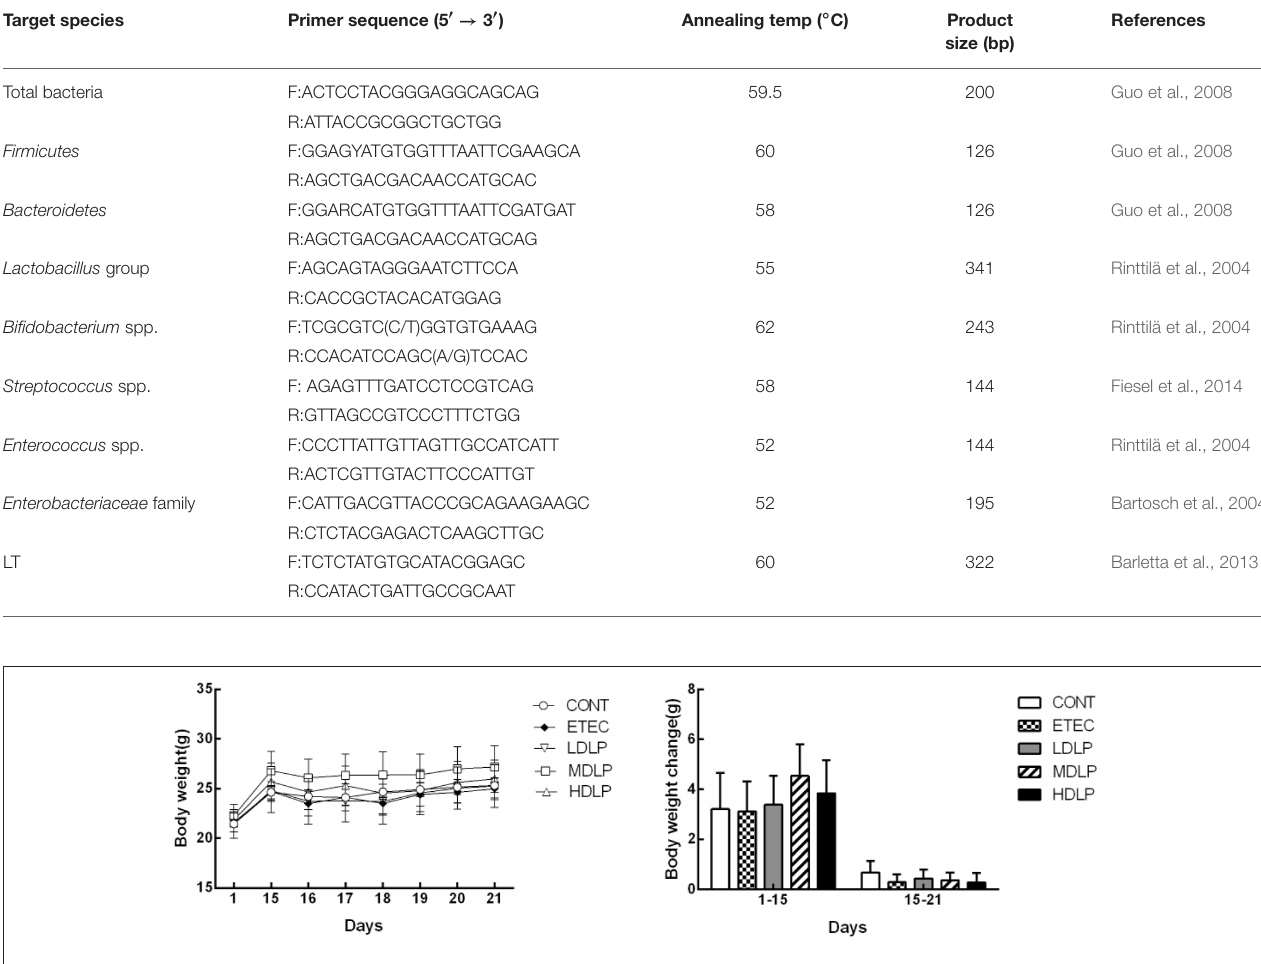
FIGURE 1 | Dose effect of Lactobacillus plantarum on the body weight of mice during pre- and post-challenge periods ( n = 6). CONT, control group, treatment with PBS at all period; ETEC, negative group, oral challenge with ETEC on day 15; LDLP, low dose (5.0 × 10 8 cfu mL − 1 ) group; MDLP, intermediate dose (5.0 × 10 9 cfu mL − 1 ) group; HDLP, high dose (5.0 × 10 10 cfu mL − 1 ) group; LDLP, MDLP, and HDLP groups were infected with ETEC at day 15. There was no significant ( P > 0.05) in all